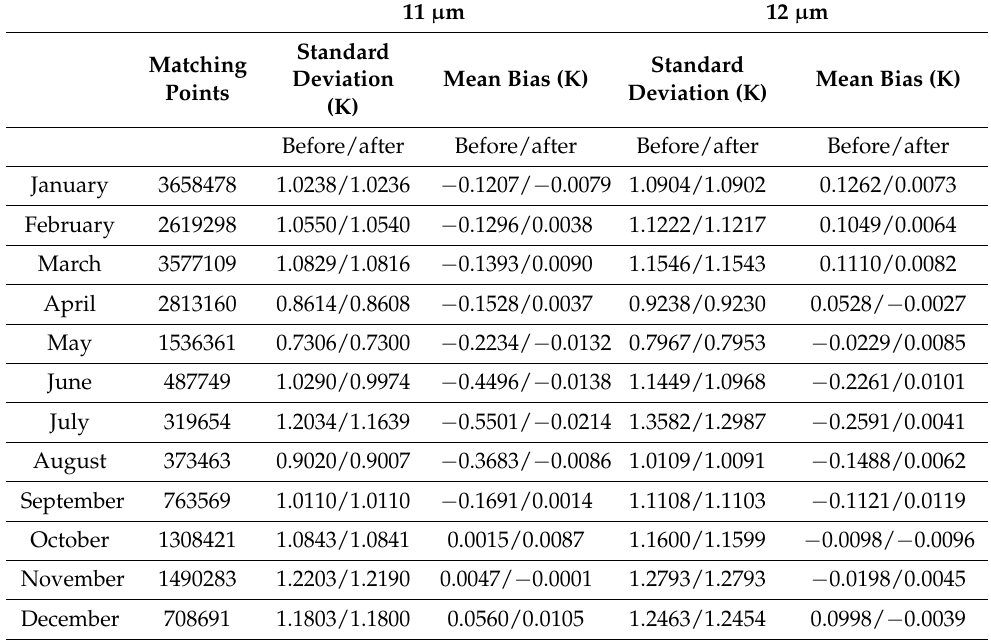
Table 6. Analysis of the monthly thermal infrared T b data between MERSI and MODIS before and after calibration.